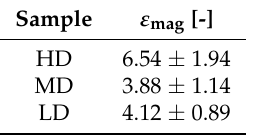
Table 4. Equivalent strain magnification ( ε mag ) at the apparent ultimate point. The results are presented as the mean value and standard deviation for each foam